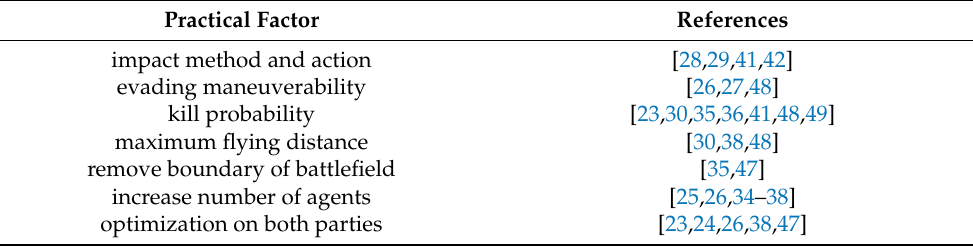
Table 2. Suggested practical factors for relevant works in Section